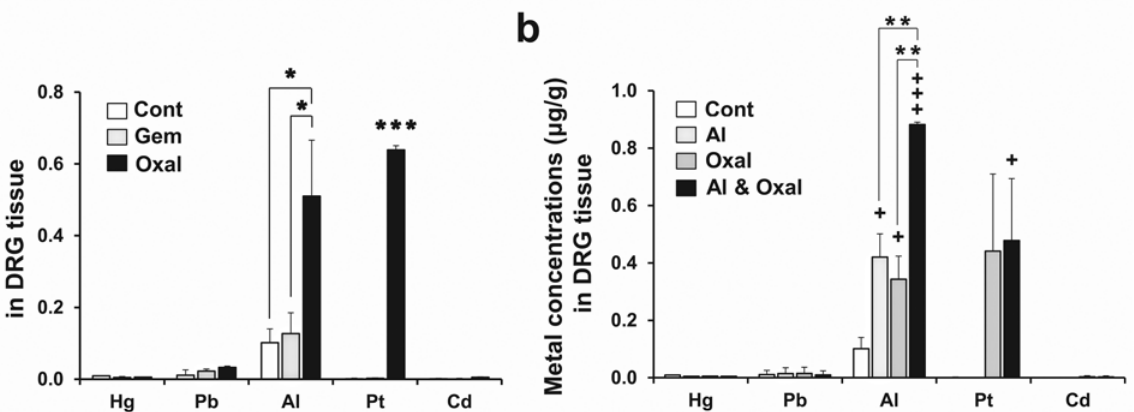
Fig 4. Accumulation of aluminum (Al) and Platinum (Pt) in DRG tissue after drug treatment. Total elemental contents including Al and Pt were assayed in DRG tissues by inductively coupled plasma mass spectrometry (ICP-MS) after performing treatments for 30 days according as the schedules shown in Figs 1a (a) and 3a (b). Al accumulated to significantly higher concentrations in the DRG from the Oxal (oxaliplatin 3 mg/kg) group than in the DRG from Cont (5% dextrose) or Gem (gemcitabine 100 mg/kg) groups ( n = 6 per group) (a). Effect of combined treatment with oxaliplatin and aluminum chloride on the elemental composition of DRG tissues. The DRGs from the Cont (5% dextrose), Al (aluminum chloride 7 mg/kg), Oxal (oxaliplatin 3 mg/kg), Al & Oxal (aluminum chloride 7 mg/kg; equivalent 0.78 mg/kg of elemental Al, oxaliplatin 3 mg/kg) groups were analyzed by ICP-MS. Al concentrations increased synergistically in tissues of the combined-treatment group compared to the Al or Oxal groups ( n = 10 per group) (b). Results are representative of two independent experiments. Values are expressed as the mean ± SEM. * p < 0.05, *** p < 0.001 compared with the Gem group, + p < 0.05, +++ p < 0.001 compared with the Cont group, ** p < 0.01 compared with Oxal and Al & Oxal.